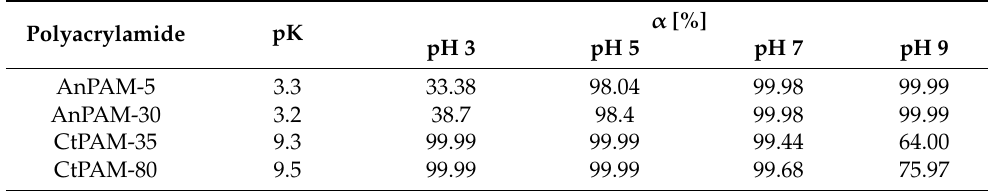
Table 3. Characteristics of dissociation of the examined polyacrylamides as a function of the solution pH.